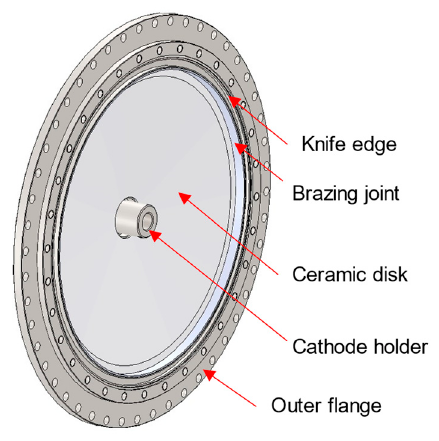
Figure 10. Output switch field distribution.